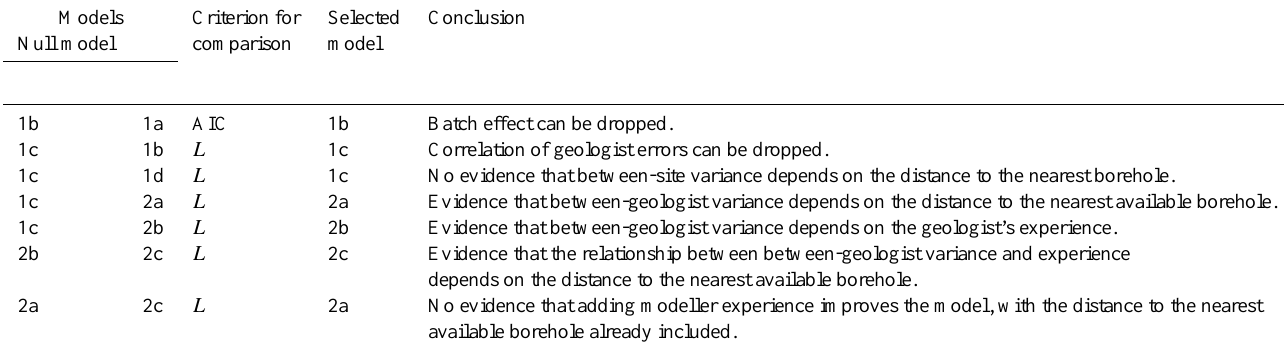
Table 6. Summary of model comparisons. In each case, the first-named simpler “null” model is compared with a more complex alternative, either on the log-likelihood ratio L or Akaike’s information criterion (AIC). The key conclusion from the comparison is indicated. Models